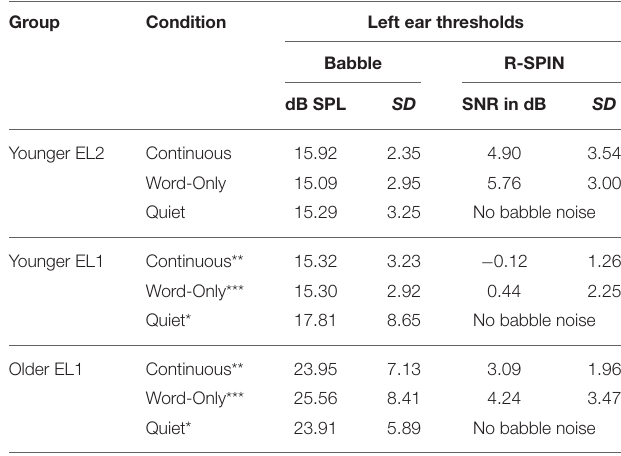
TABLE 2 | Babble and SPIN thresholds in the left ear for each of the conditions and